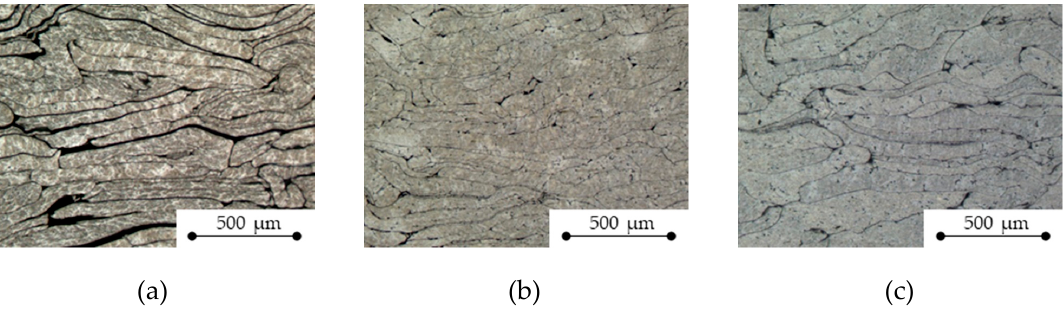
Figure 10. The optical microstructure of the composite at the parameters set as the ( a ) minimum, ( b ) intermediate, and ( c ) maximum.